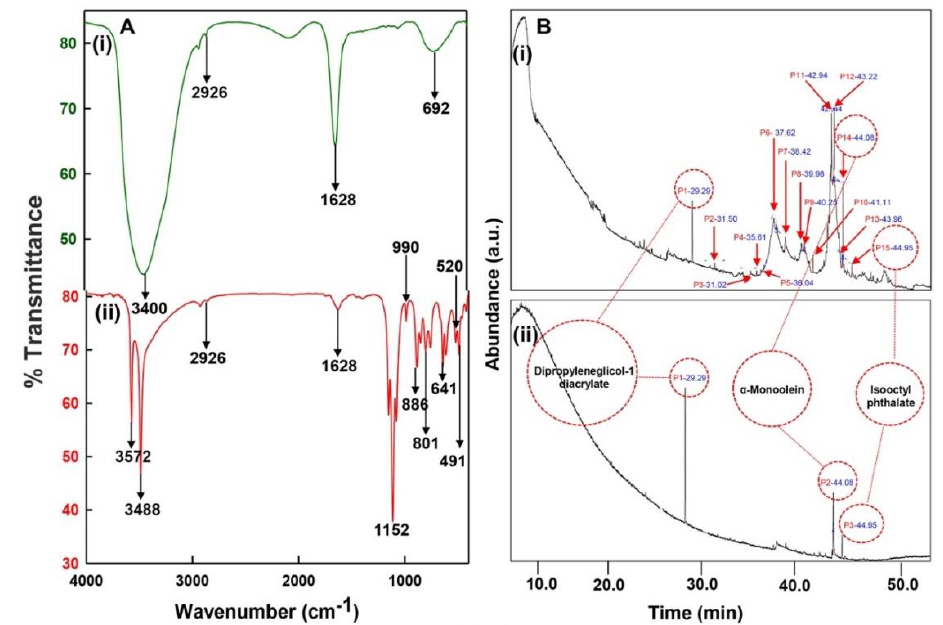
Figure 4. FTIR and GC-MS analyses of CLE and CLE-CuONPs. ( A ) comparison of FTIR spectra of CLE (spectrum-i) and CLE-CuONPs (spectrum-ii); ( B ) GC-MS analysis (spectrum-i) shows a typical chromatogram of CLE indicating 15 peaks of different bio-actives. Spectrum-ii shows three CLE compounds: dipropyleneglycol-1 diacrylate, α-monoolein, and iso-octyl phthalate associated with CLE-CuONPs.